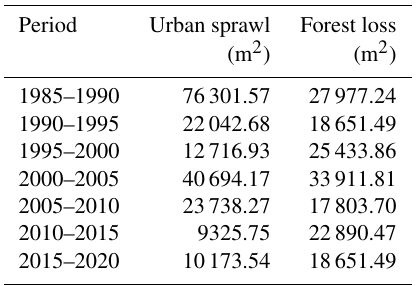
Table 4. Urban sprawl and forest loss classes in the area of